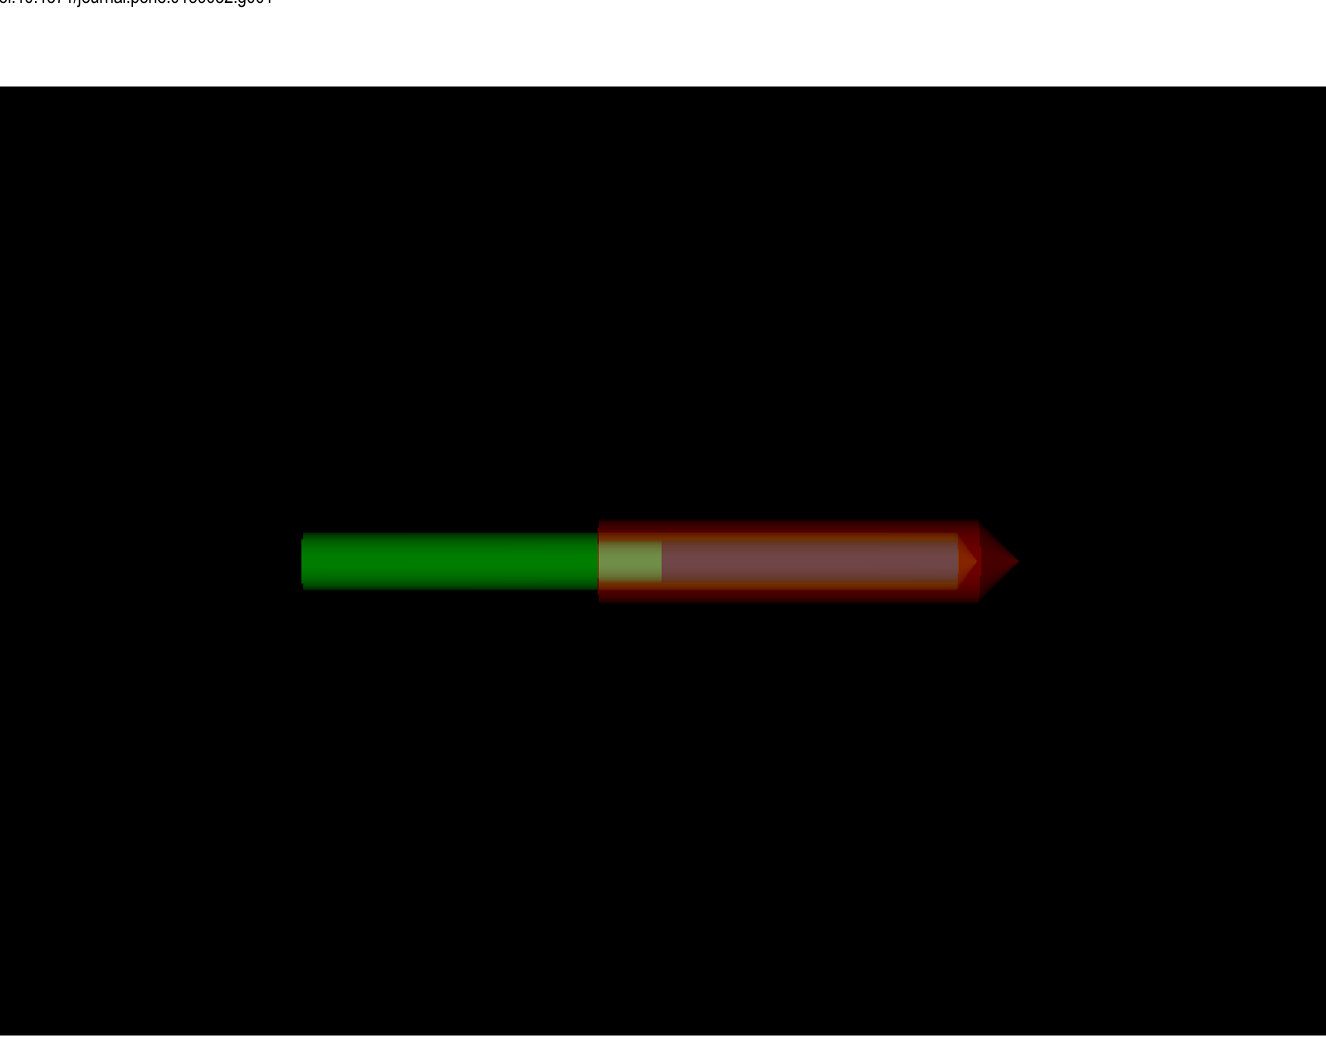
PLOS ONE | DOI:10.1371/journal.pone.0139032 September 29,